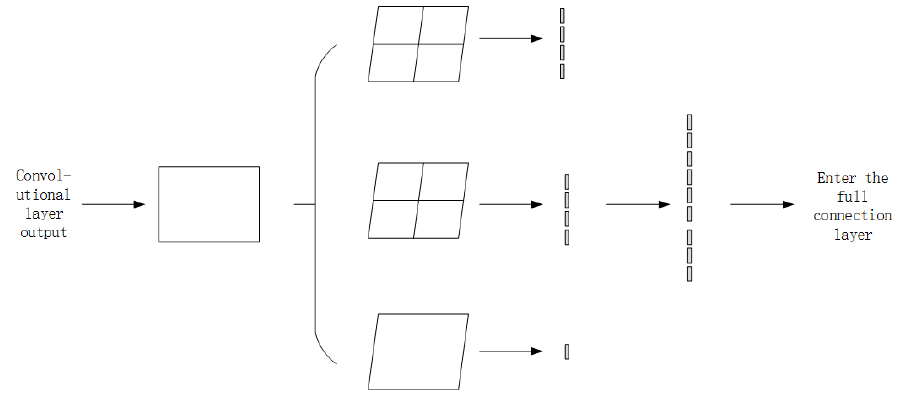
Figure 4. Process of adding